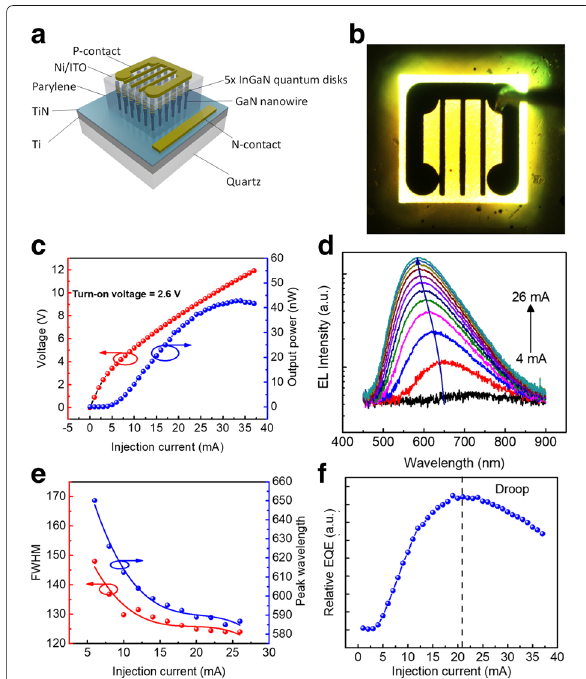
Fig. 5 a Schematicof the fabricated LED device. b Optical photograph of the nanowires on quartz LED under forward bias. c L - I - V characteristic of the LED. d Electroluminescence spectra of the LED under varying injection current. e Change of FWHM and peak wavelengthpositionof the LED withincreasing forward bias. f Relative external quantum efficiency of the LED, showing efficiency droop at